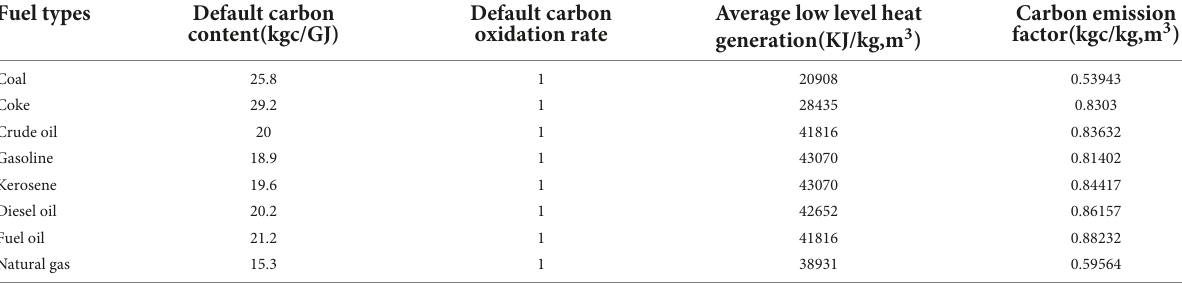
TABLE 1 Carbon emission factors for each type of fossil fuel.